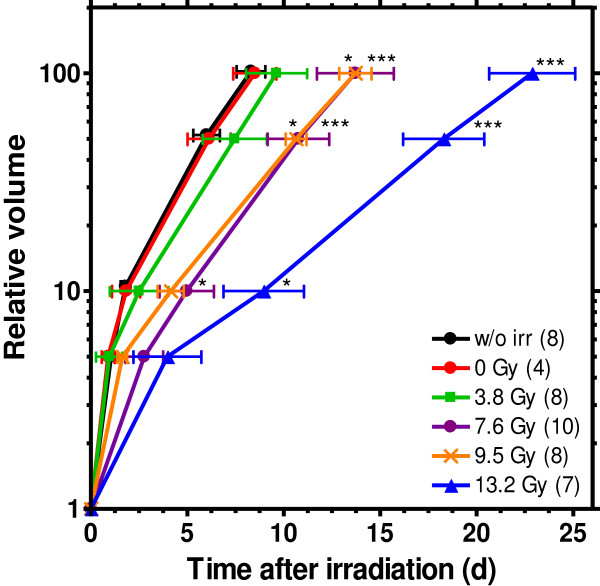
Dose dependent growth delay induced by 200 kV X-ray treatment. Tumour growth curves measured after irradiation with 200 kV X-rays (0 – 13.2 Gy) and for the untreated control (black curve, partly covered by the 0 Gy line). The relative volumes in dependence on time are determined on basis of the volumes at the start of the treatment. The numbers of animals allocated to the different groups are given in brackets; the measured data are given as mean value ± SEM of all animals in this particular group. The tumour growth delay relative to the untreated control was significant (*p < 0.05, ***p < 0.001) for doses higher than 7.6 Gy for the 10fold volume increase and for doses higher than 3.8 Gy at higher volume increases, respectively.